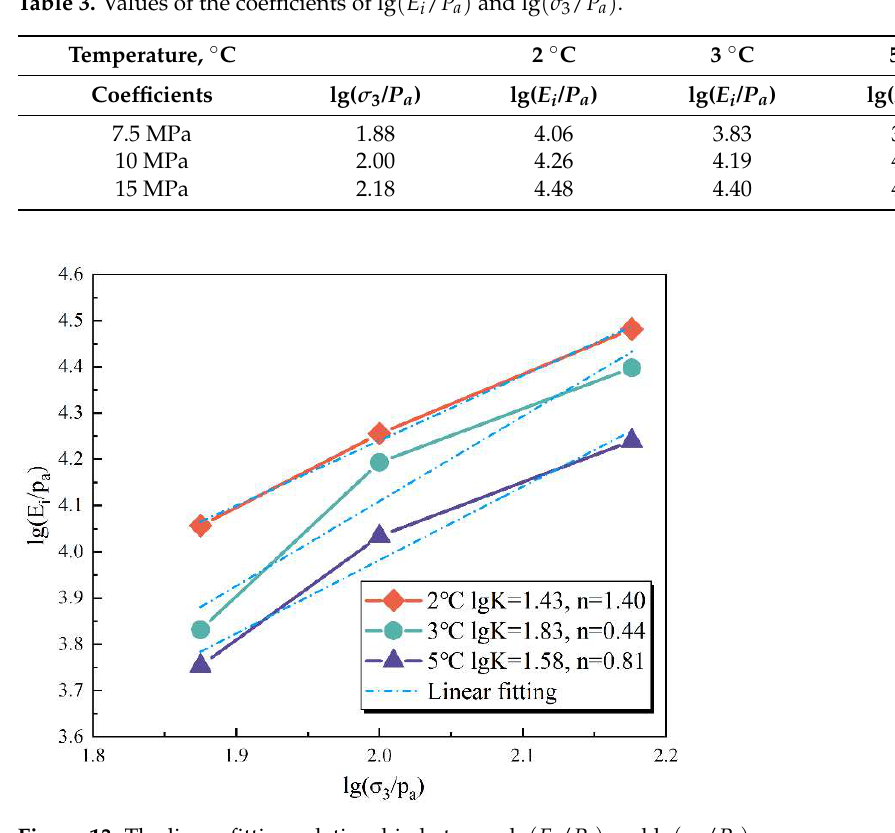
Figure 14. Fitting of initial elastic modulus 𝐸 (cid:3036) . The damage ratio 𝑅 (cid:3033) = 𝑞 (cid:3033) 𝑞 (cid:3048)(cid:3039)(cid:3047) ⁄ can be transformed through Equation (5) as 𝑅 (cid:3033) = 𝑏𝑞 (cid:3033) , and the calculated values of 𝑅 (cid:3033) are shown in Figure 15. The dependence of 𝑅 (cid:3033) on confining pressure and temperature is not clear. 𝑅 (cid:3033) holds for a variety of soils ranging from 0.7 to 1. For simplicity, 𝑅 (cid:3033) is set as a constant independent of confining pressure and temperature as 𝑅 (cid:3033) = 0.92 .